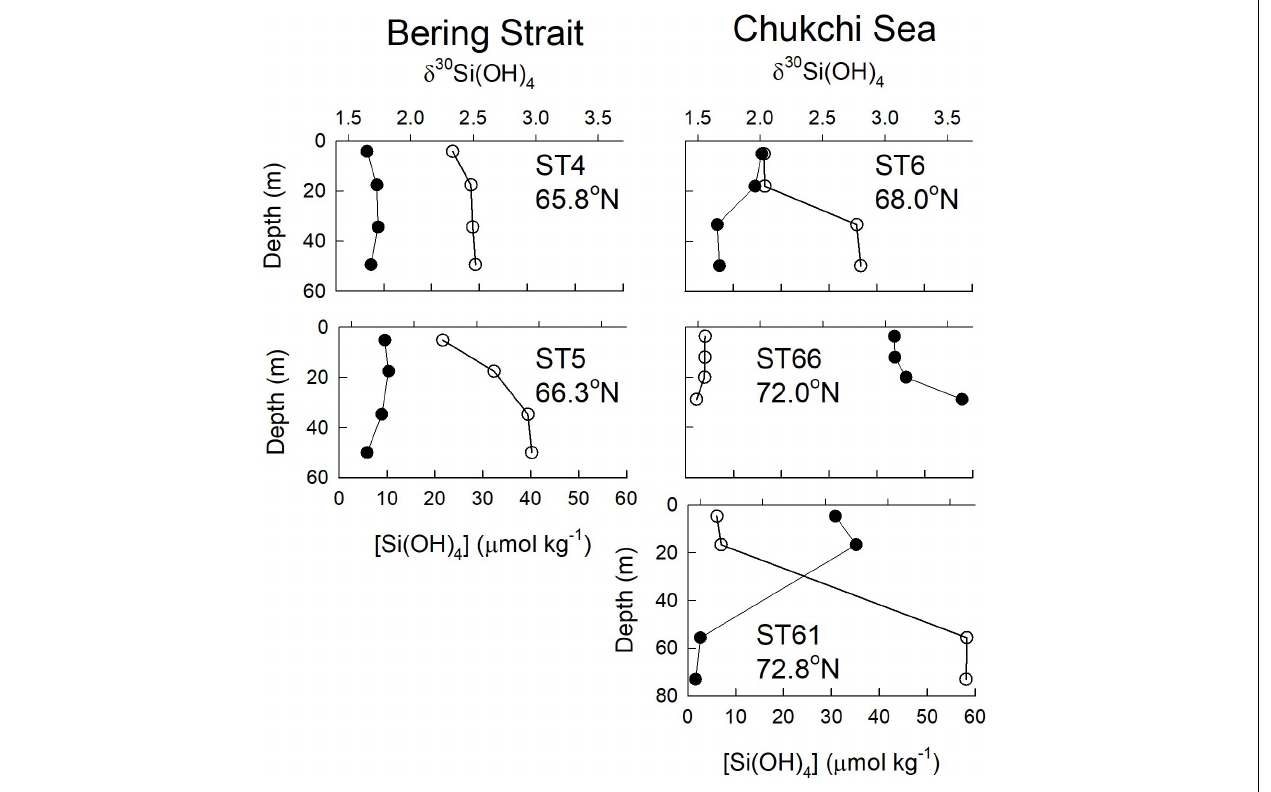
FIGURE 2 | Profiles of silicic acid concentration (open circles) and δ 30 Si(OH) 4 (filled circles) for stations in the Bering Sea (stations 4 and 5) and Chukchi Sea (Stations 6, 61, and